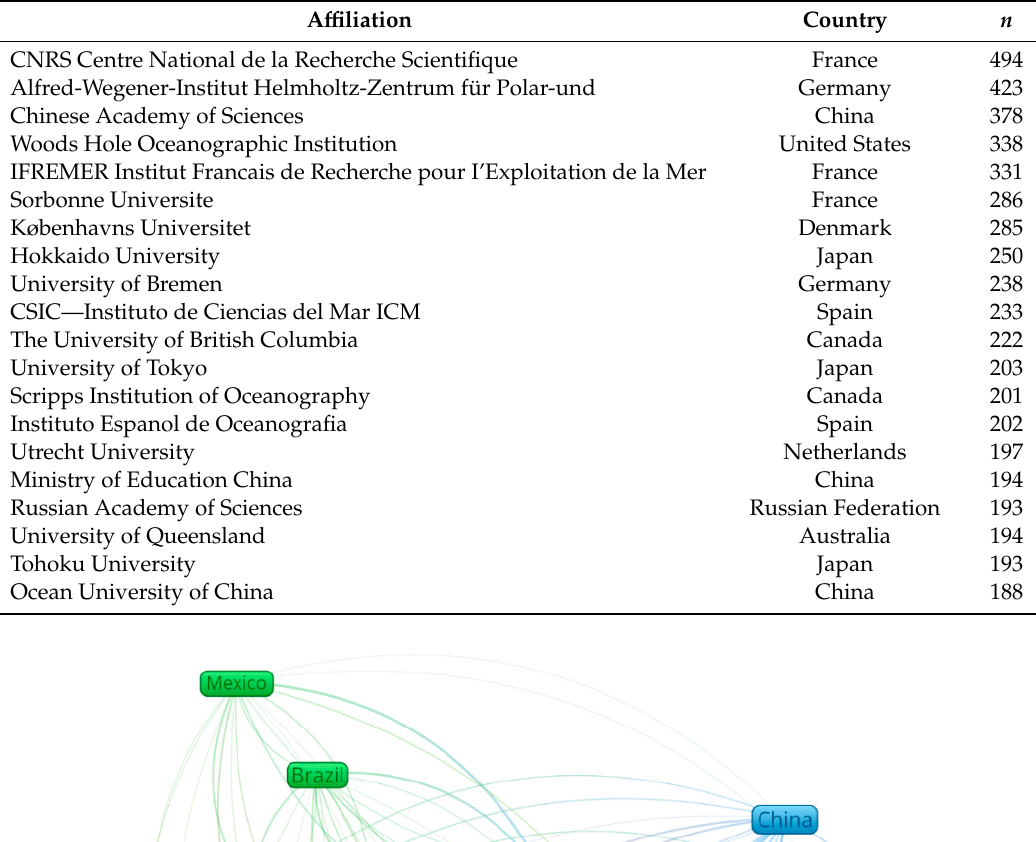
Table 2. Top 20 research centers.